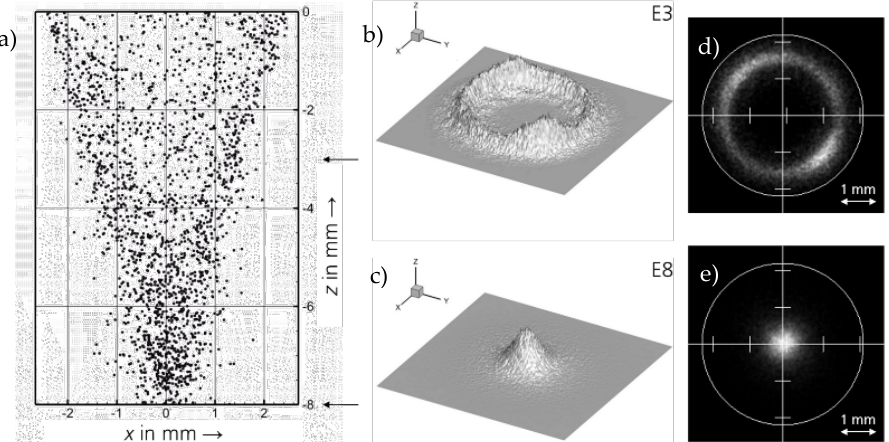
Figure 16. ( a ) Lateral view of the simulated powder-gas jet; ( b , c ): Simulated particle density distribution Figure 16. (a ) Lateral view of the simulated powder-gas jet; ( b ) and ( c ): Simulated particle density for levels E3 and E8. ( d , e ) 3000 superimposed images of measurements for levels E3 and E8. Parameters: distribution for levels E3 and E8. ( d ) and ( e ) 3000 superimposed images of measurements for levels . m p = 5 g / min, V FG = 5 L / min, V SG = 10 L / min [1]. Reprinted with permission grain fraction − 53 + 20 µ m, E3 and E8. Parameters: grain fraction − 53 + 20 µm, = 5 g/min, V FG = 5 L/min, V SG = 10 L/min [1]. from Ref [1]. Copyright 2020, Fraunhofer Reprinted with permission from Ref [1]. Copyright 2020, Fraunhofer Verlag. 𝑚𝑚̇ 𝑝𝑝